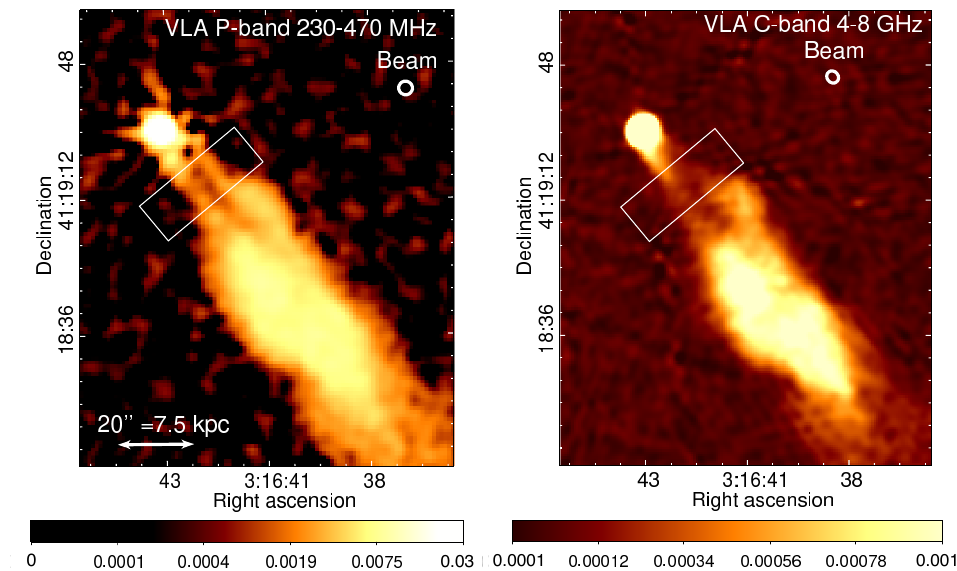
Figure 5. Taken from [55], these high-resolution VLA images of IC310 show a zoomed-in region at the base of the jets. The left panel image from 320–470MHz radio observations shows two distinct jets that are collimated, narrow, and oriented in the same general direction. The right panel image taken at higher radio frequencies of 4–8GHz shows the same jet features, but closer to the nucleus, these are less distinguishable compared to the low-frequency observations. γ -ray emission most likely originates close to the SMBH in a region oriented close to our line-of-sight, where Doppler boosting takes place and before the jets are